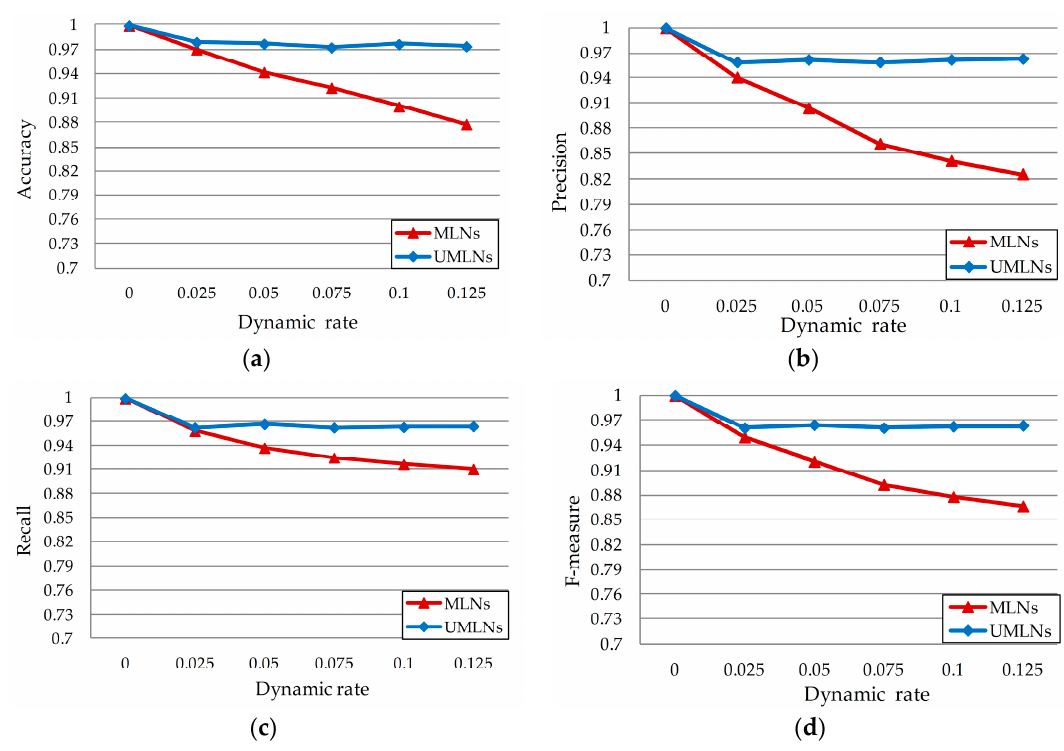
Figure 5. Dynamic event recognition for low frequency events with respect to four scales, ( a ) Accuracy; ( b ) Precision; ( c ) Recall; ( d ) F-measure .